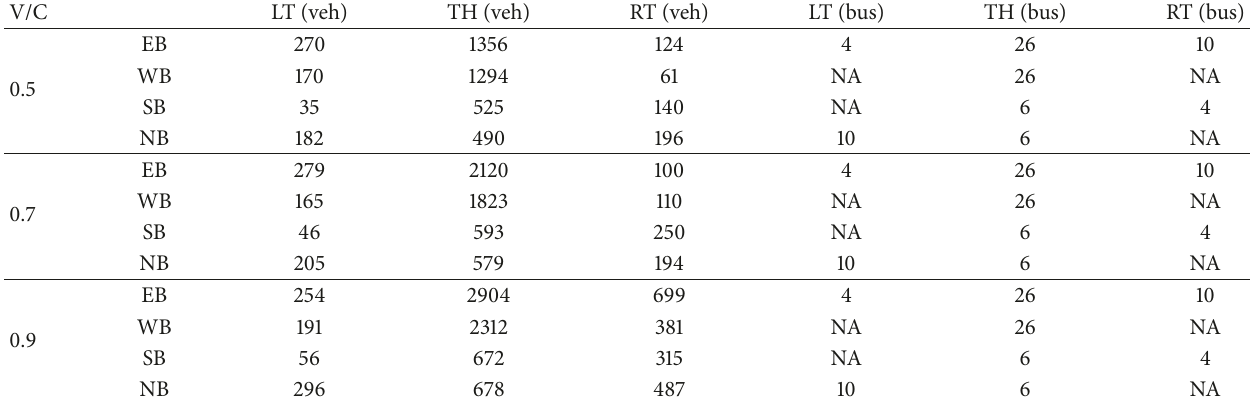
Table 1: Traffic volumes at the